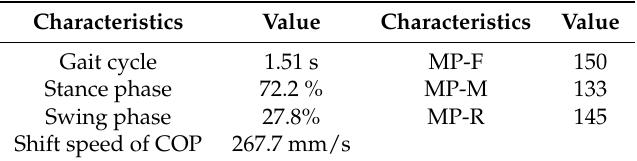
Table 1. The participant characteristics were obtained during a walking